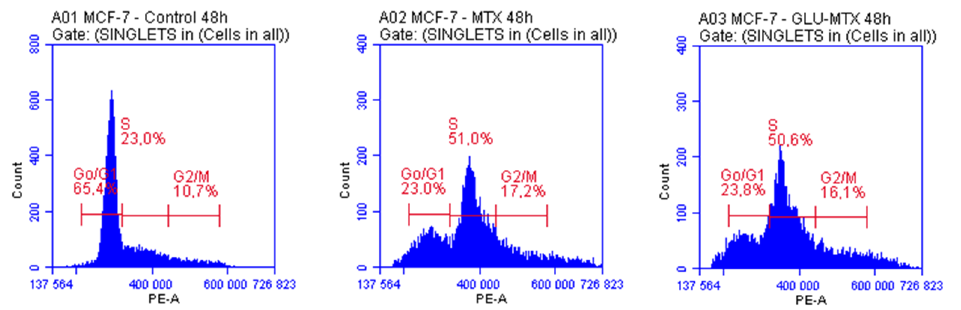
Figure 5. The effect of MTX and GLU–MTX on MFC-7 cell cycle progression. Table 1. Cell cycle progression data presented as mean ± standard deviation (SD).